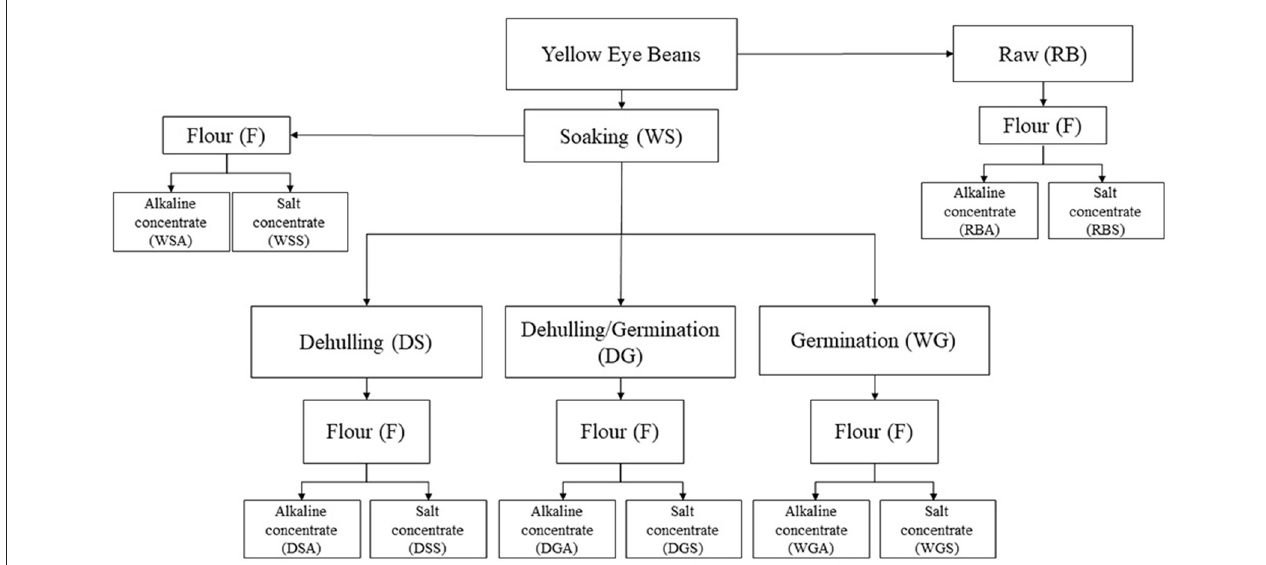
FIGURE 1 | Sample preparation of pre-treated (soaked, dehulled, germinated, and dehulled and germinated), Yellow Eye beans and the subsequent protein concentrates generated using salt and alkaline protein extraction solutions.